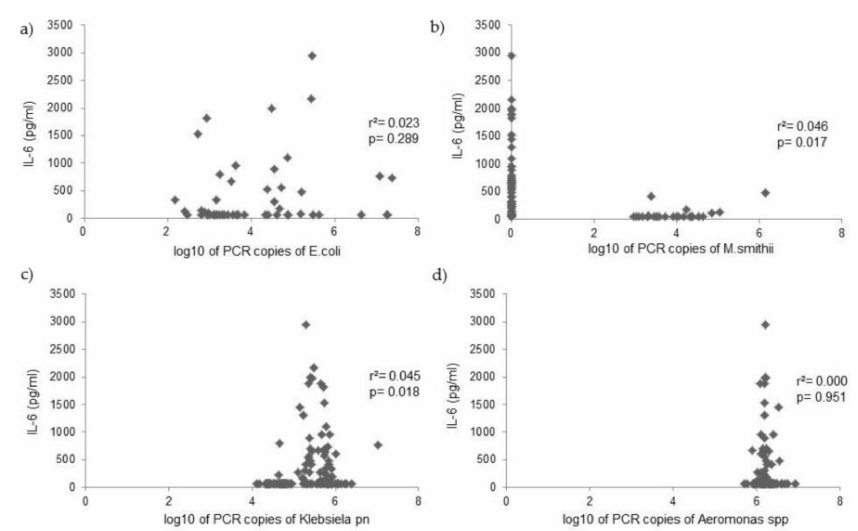
Figure 3. Correlation between IL-6 levels and PCR copies of ( a ) Escherichia coli , ( b ) Methanobevribacter smithii , ( c ) Klebsiella pneumoniae , and ( d ) Aeromonas spp. in the duodenal fluid.